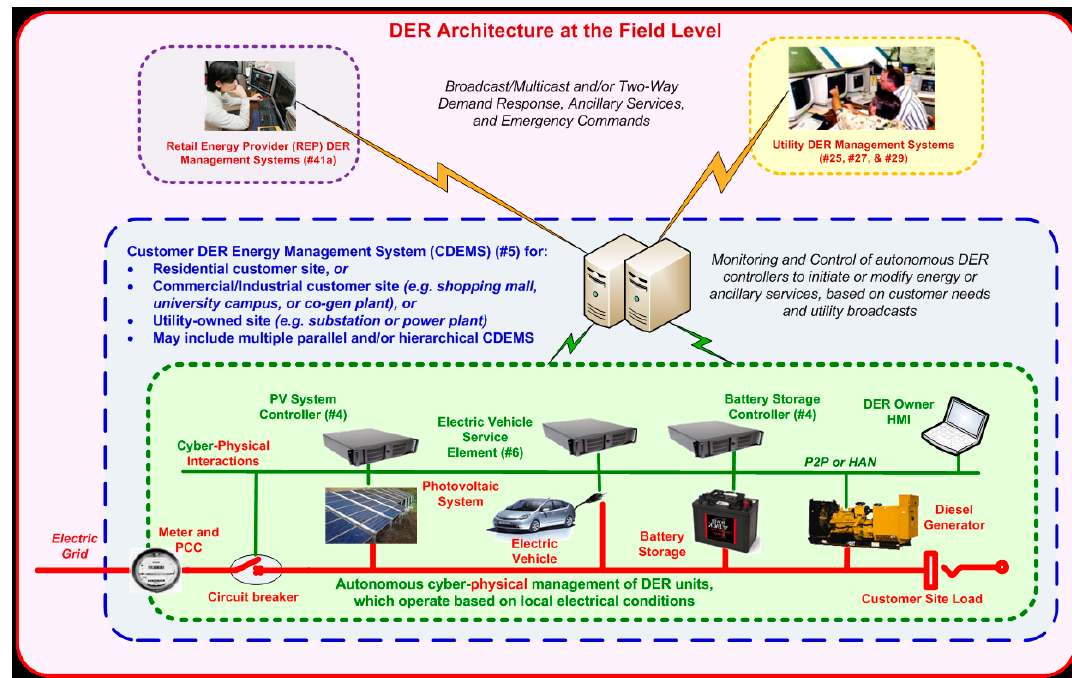
Figure 1. Interface of Distributed Generations (DGs) under IEC 61850-90-7 [21]. DER: Distributed Energy Resources; PCC: Point of Common Coupling, P2P: Peer-to-Peer, HMI: Human-Machine Interface, HAN: Home Area Network.